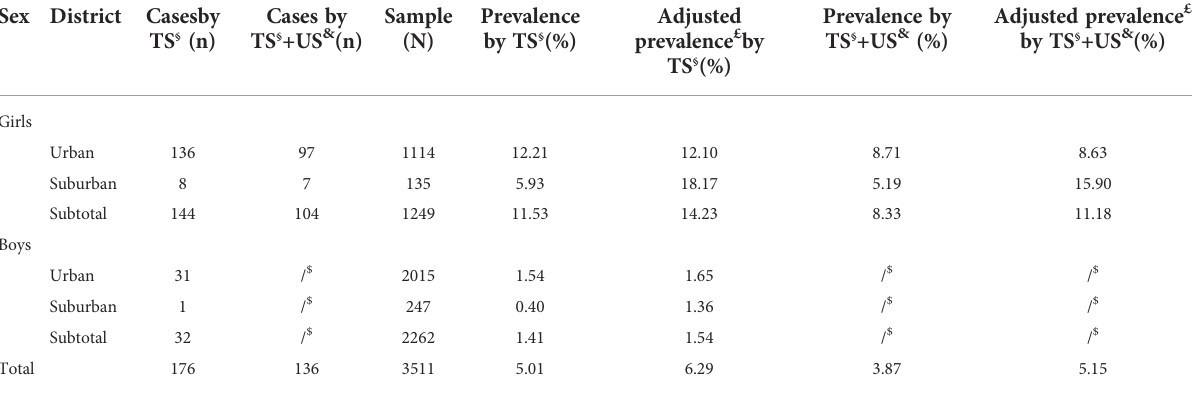
TABLE 3 Prevalence of precocious puberty in urban and suburban areas according to